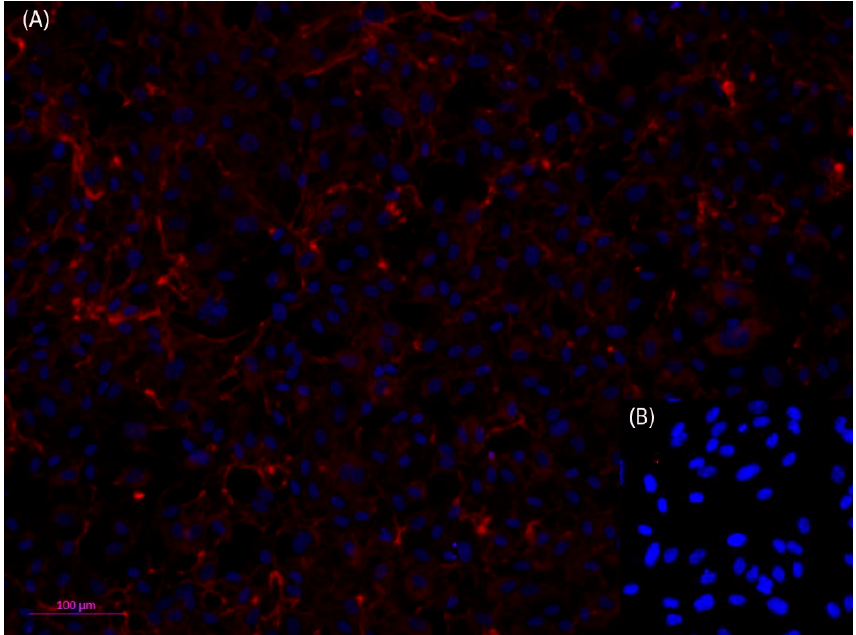
Figure 3. Fluorescent microscopic photos of anti-Collagen IV, Cy3 (red) immunofluorescence staining of human primary pulmonary arterial endothelial cells (HPAEC) ( A ); nuclei stained with Hoechst dye (blue). Collagen IV can be detected both in the cytosol of the cells as well as outside of the cells, which indicates that the HPAEC cells have formed an adequate basement membrane ( B ). The negative control shows that the method has been used appropriately. Dilution of antibodies: 1st antibody anti collagen IV 1:50, and 2nd antibody Cy3 anti rabbit 1:500). Scale bar 100 µm.